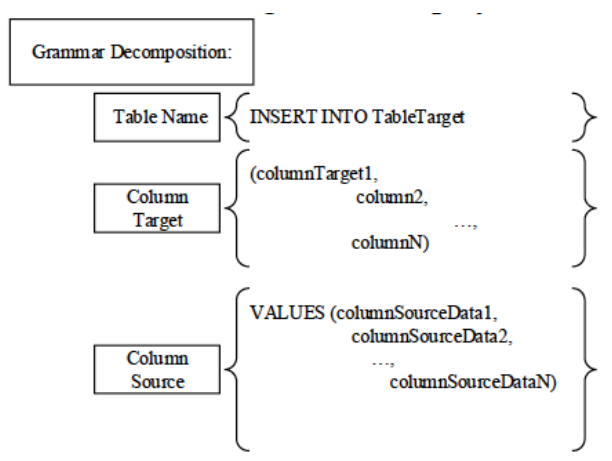
Fig. 5. Grammatical case of inclusion of one decomposition.